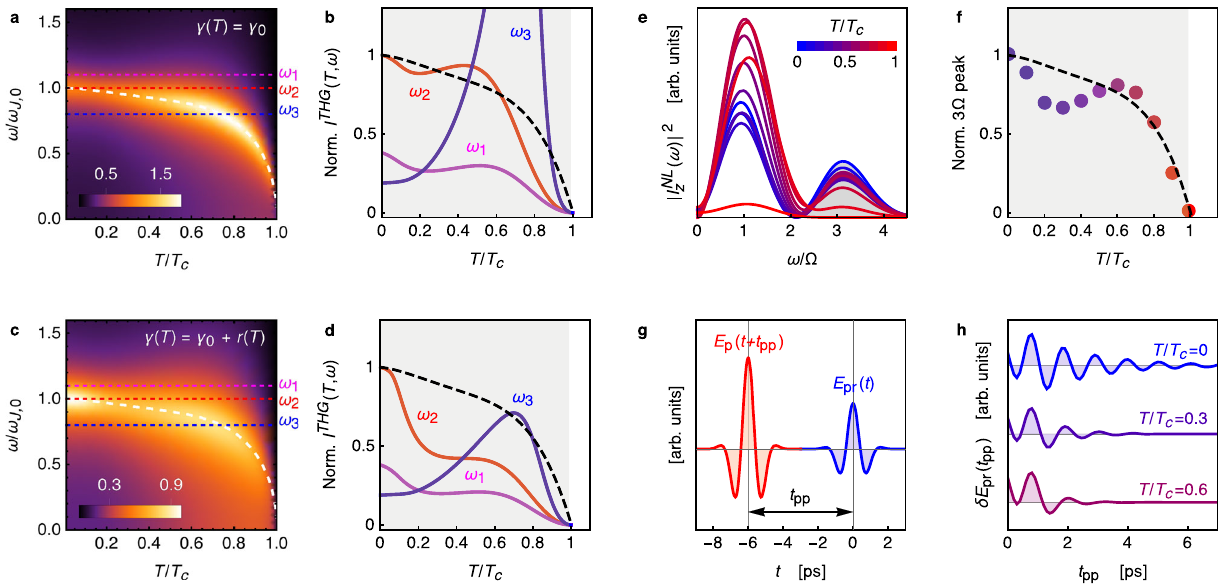
Fig. 2 Non-linear excitation of out-of-plane JPM. a – d Narrow-band pulse. Temperature and frequency dependence of the non-linear kernel (7) ∣ K (2 ω , T ) ∣ , normalized to its T = 0 value for the pumping frequency ω = ω J ,0 , for constant a and temperature-varying c damping γ . The dashed line denotes ω J ( T )/ ω J ,0 . b , d show the corresponding I THG ( ω i , T ) for three values ω i of the pump frequency, normalized to its T = 0 value for the pumping frequency ω 2 = ω J ,0 . The dashed line represents J ⊥ ( T )/ J ⊥ (0). e – h Broadband pulse. e Spectrum of the non-linear current I NL z as a function of frequency, normalized to the central frequency Ω of the pump pulse, shown explicitly in g . The intensity of the THG signal is now obtained by integrating the peak around 3 Ω (gray region in e ). Its temperature dependence, normalized to its T = 0 value, is shown in f , with the same color code of the curves of e . g Schematic of the pump-probe setup: a weak probe fi eld E pr ( t ) impinges on the sample with a variable time delay t pp with respect to the intense pump pulse E p ( t ). g Time-dependence of the differential probe fi eld δ E pr ( t pp ) measured with and without the pump, at different temperatures. The periodicity of the oscillations matches the 2 ω J ( T ) value at each temperature. Here we set ω J ,0 /2 π = 0.47 THz in accordance with the experiments 17